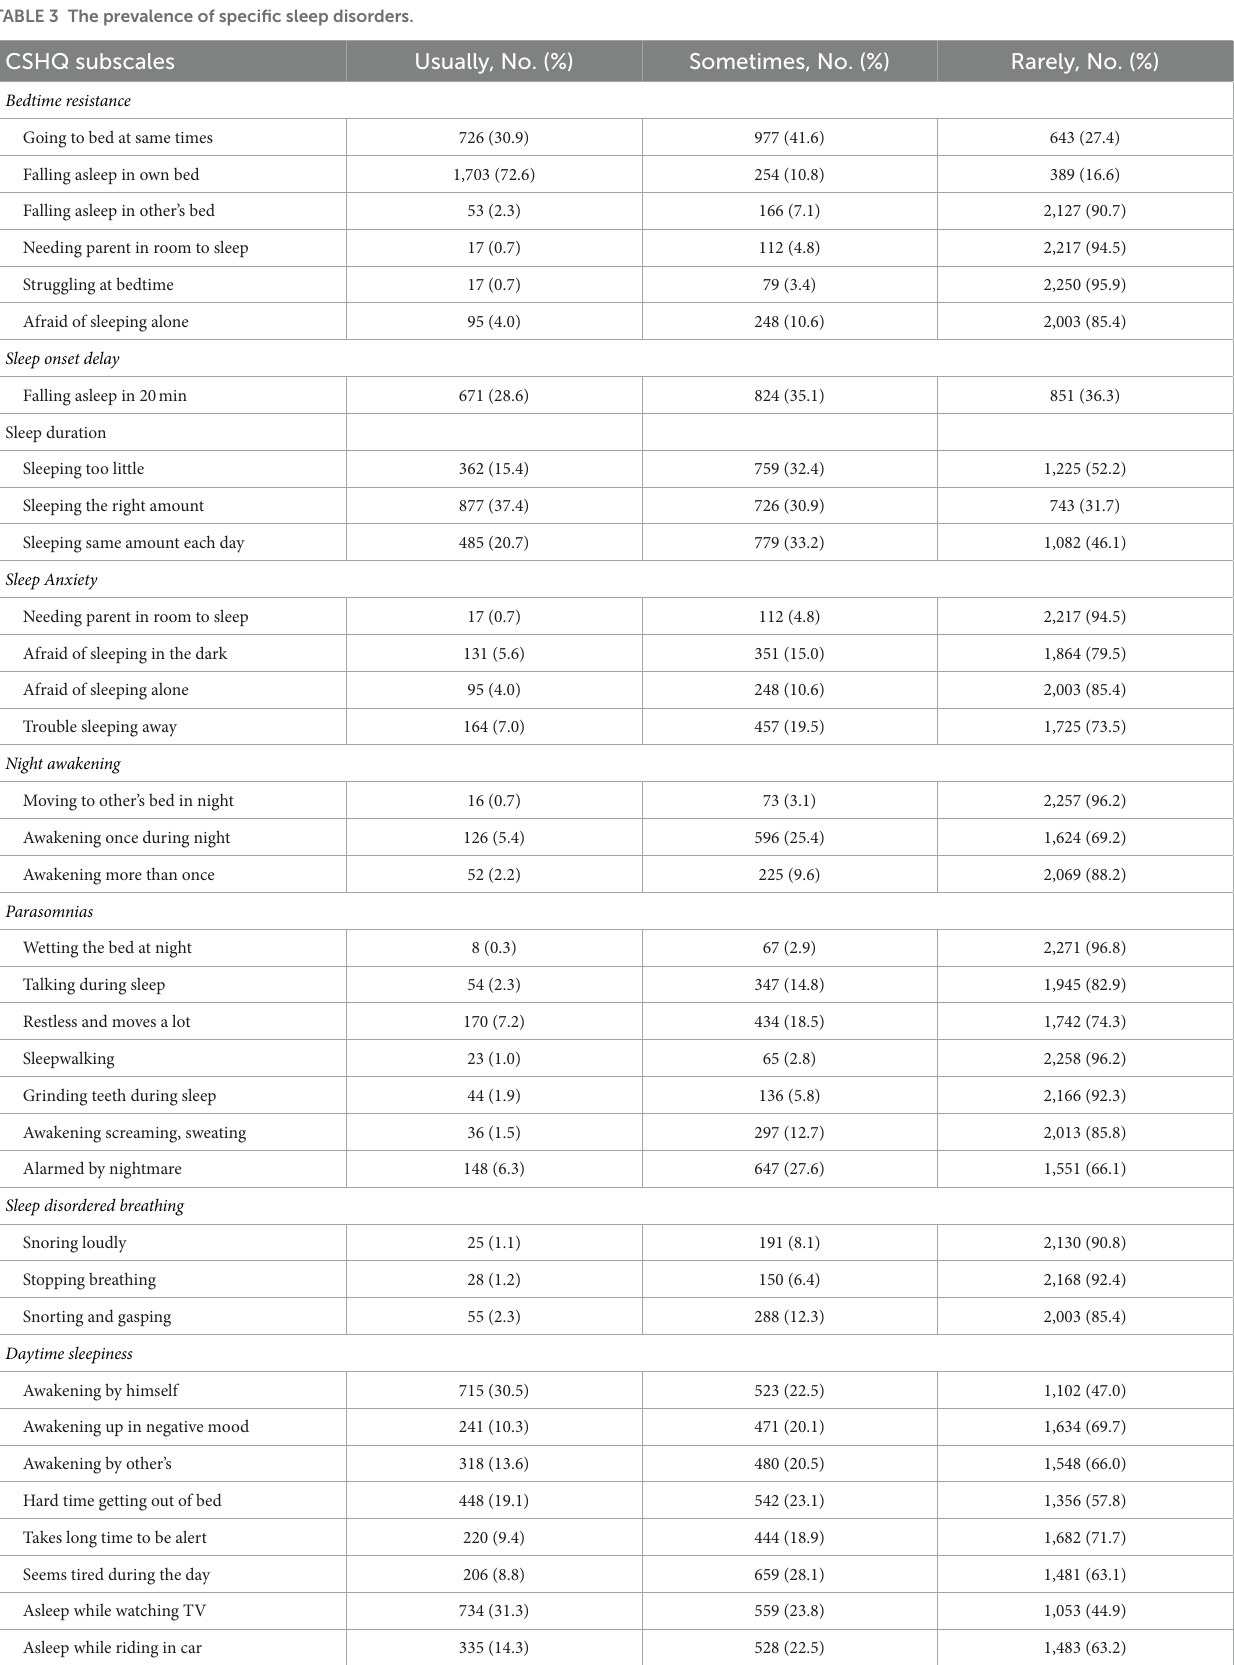
TABLE 3 The prevalence of specific sleep disorders. CSHQ subscales Usually, No. (%) Sometimes, No. (%) Rarely, No.